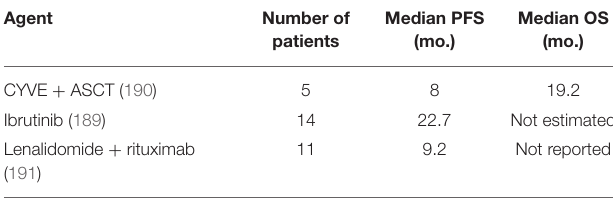
TABLE 2 | Salvage treatment regimen for PVRL in prospective clinical trials.